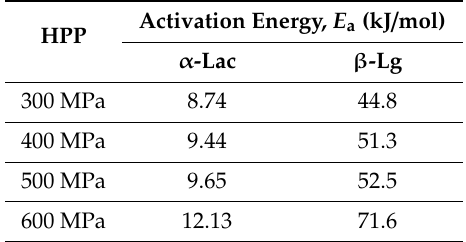
Figure 5. Effect of HPP on the rate of constant ( k ) for denaturation of β -Lg. Temperature at all HPP conditions ( T eff ) is presented in Table 1. Table 2. Activation energy ( E a ) after HPP of 300–600 MPa.